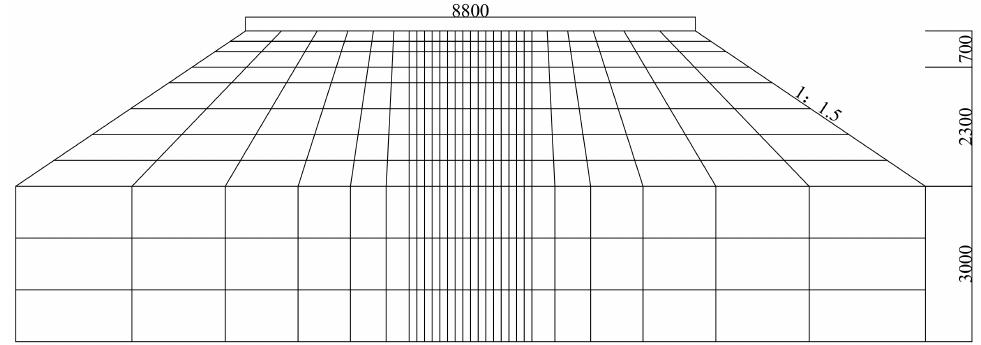
Figure 8. The schematic illustration (not to scale) of the composite subgrade system in the numerical model (unit: